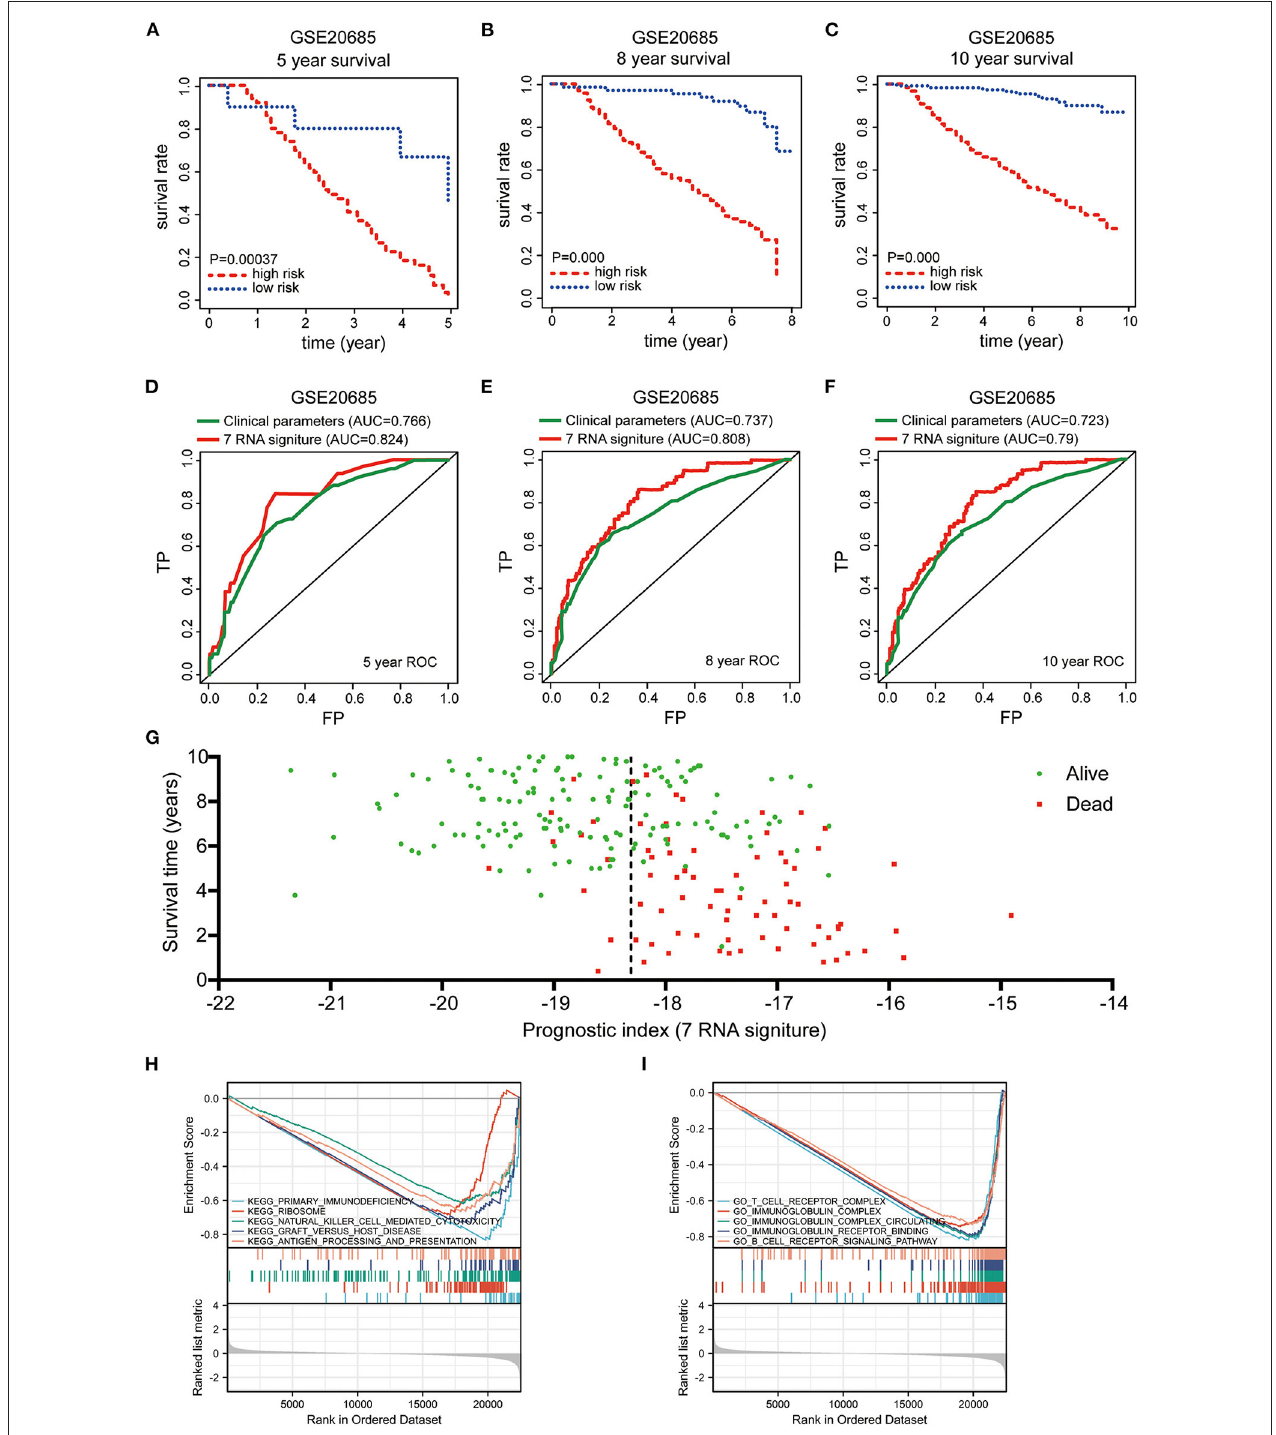
FIGURE 5 | Validation the prognostic value of pyroptosis-related gene signature in GSE 20685 and GSEA enrichment analysis for pyroptosis-related gene signature in TCGA-BRCA. (A–C) Kaplan-Meier survival curves were employed to validate the prognostic power of pyroptosis-related gene signature in GSE 20685 at 5-, 8-, and 10-years survival rates, respectively. (D–F) Time-dependent ROC curves were used to assess the prognostic value of the risk signature in the GSE 20685 dataset at 5-, 8-, and 10-years, respectively. (G) Scatter plot were used to indicate the survival status of each Breast cancer case from GSE 20685. “Dead” and “Alive” were represented by red and green dots in (G) , respectively. (H) KEGG and (I) GO pathway enrichment analysis for pyroptosis-related gene signature between low- and high-risk group in TCGA-BRCA cohort.